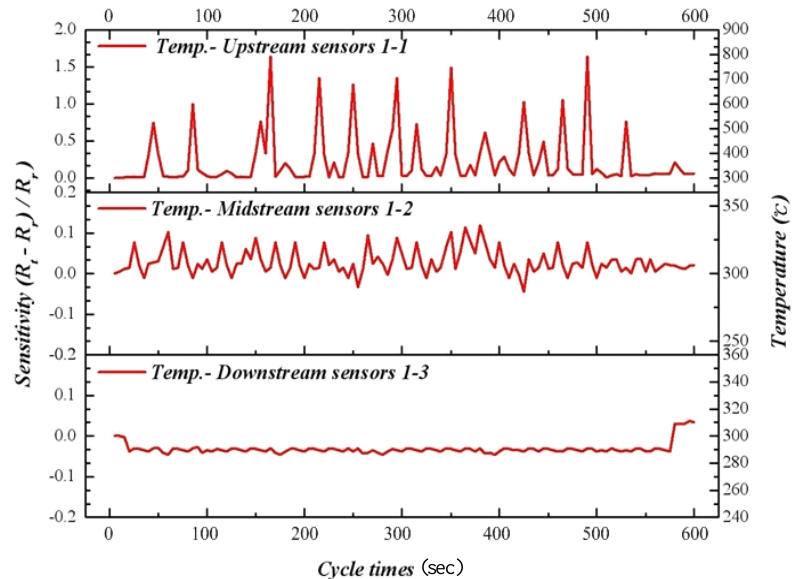
Figure 11. Inner temperature distribution of micro reformer at area 1-1, 1-2, 1-3 (OSRM; 300 